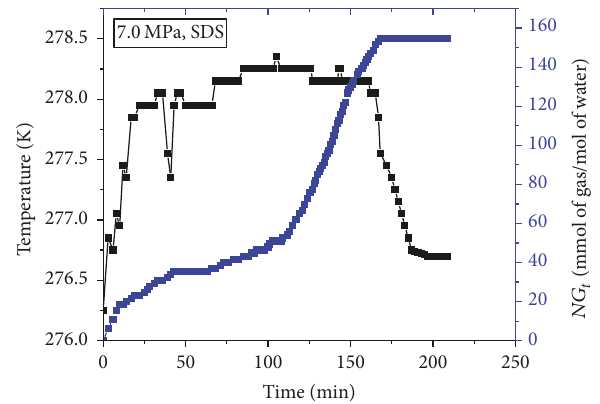
Figure 4: Hydrate formation in 300 ppm SDS solution at 7.0 MPa.